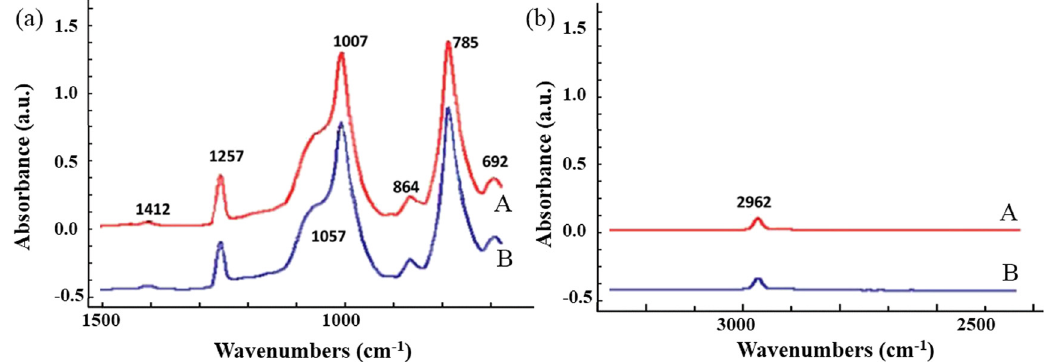
Figure 2: IR spectra for ( A ) unexposed specimens and ( B ) aged specimens in RS for 33 days at 70°C. ( a ) Wavenumbers from 650 to 1,500 cm − 1 , and ( b ) wavenumbers from 2,500 to 3,500 cm − 1 .